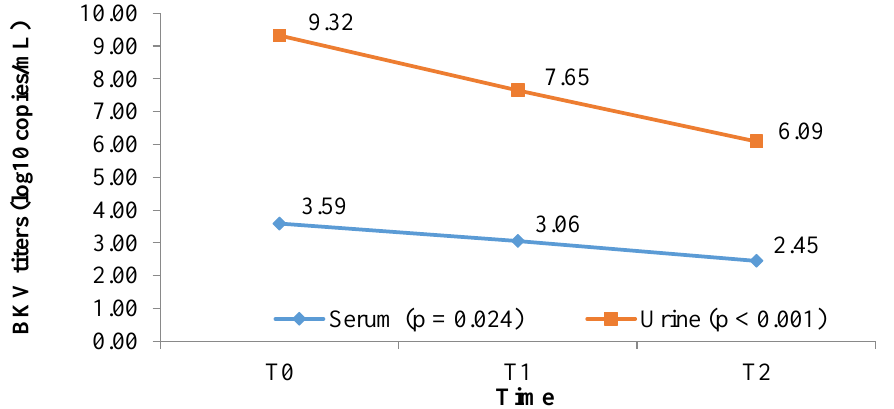
Figure 3. BKV viremia and BKV viruria titers during the 6-month follow-up period in 41 patients who completed follow-up time ( p = 0.024 for serum; p < 0.001 for urine; both ANOVA for repeated measures) .